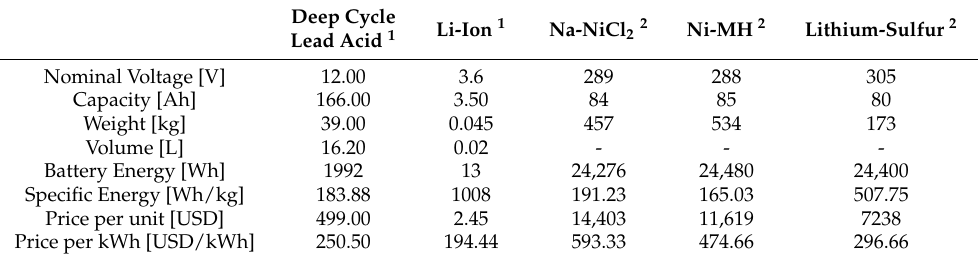
Table 3. Batteries’